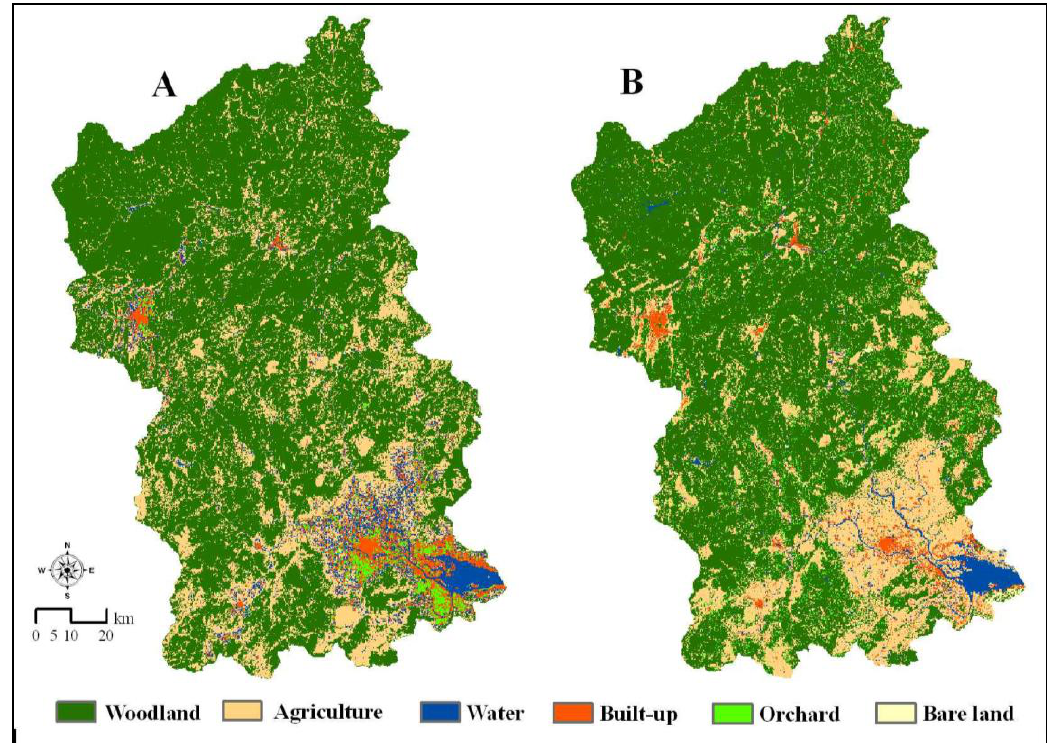
Figure 3. LULC maps of 2002 for the Jiulong River Watershed classified by ( A ) stratified and ( B ) unstratified classification.